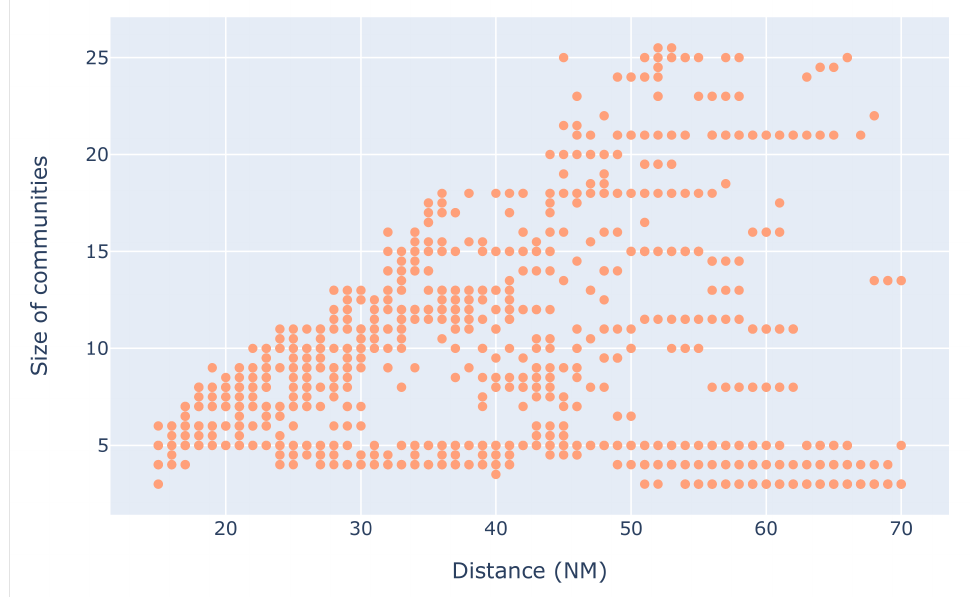
Figure 26. Size of communities for different distance